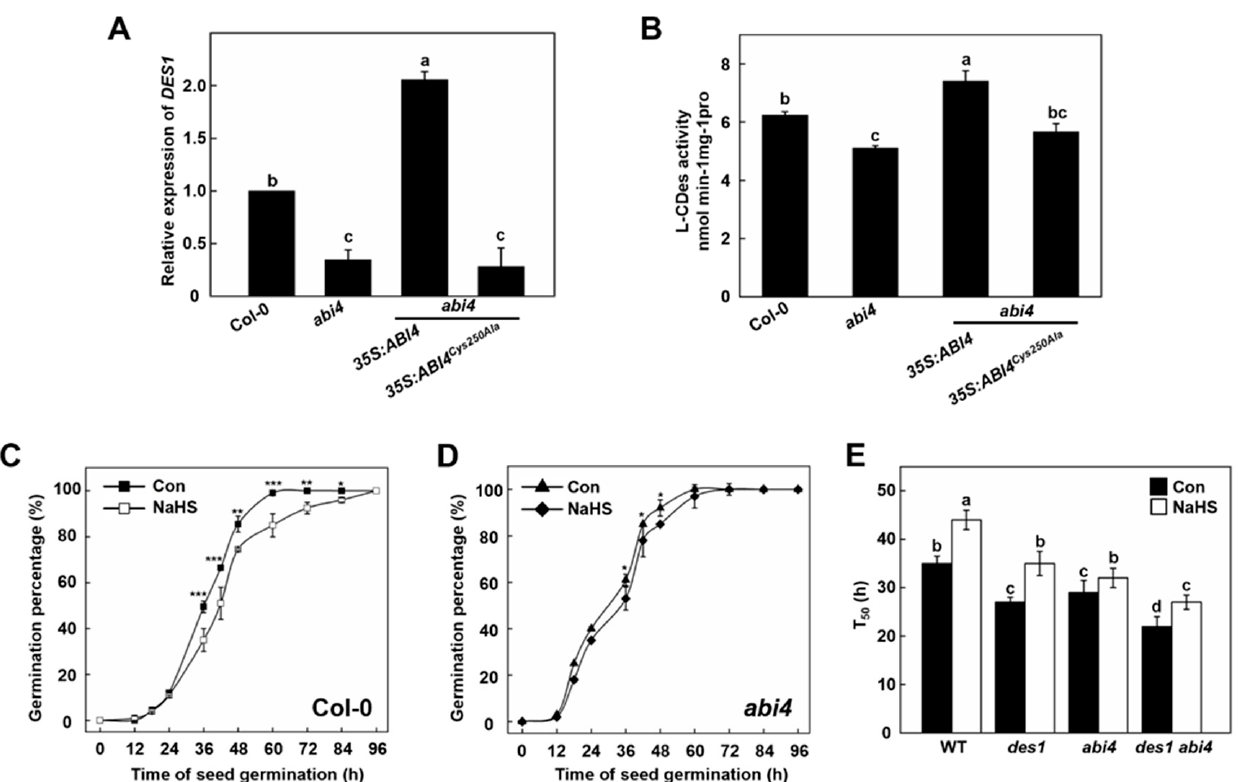
Figure 2. Functional analysis of DES1 and ABI4 on seed germination and post-germination growth. ( A , B ) Relative expression of DES1 ( A ) and L-CDes activity ( B ) in Col-0, abi4 , 35S:ABI4 abi4 , and 35S:ABI4 Cys250Ala abi4 Arabidopsis seedlings. Five-day-old seedlings were collected for qRT-PCR analysis and measurement of L-CDes enzyme activity, respectively. Expression levels are presented relative to that of UBQ10 , with DES1 expression in the Col-0 set to 100%. ( C , D ) Time-course changes of germination percentage in Col-0 and abi4 Arabidopsis seedlings upon NaHS treatment. Arabidopsis seeds were incubated on 1 / 2 MS medium containing 0.1 mM NaHS, respectively. The germination percentage (%) of seeds was counted at the indicated time points. ( E ) The time to obtain 50% of germinated seeds in WT, des1 , abi4 , and des1 abi4 seeds with or without 0.1 mM NaHS. Data are mean ± SE of three independent experiments with three biological replicates for each individual experiment. Bars with different letters indicate significant differences at p < 0.05 according to one- way ANOVA (post-hoc Tukey’s HSD test). Con: control. Asterisks represent significant differences between treatments according to Student’s t -test (* p < 0.05, ** p < 0.01, *** p < 0.001). Time-course changes of germination percentage were examined in WT and abi4 Ara- bidopsis seedlings upon NaHS treatment. While the germination speed of abi4 is faster than wild-type, NaHS-triggered inhibitory response in germination is weakened by the mutation of ABI4 (Figure 2C,D). The germination rates of des1 and abi4 mutant lines were further compared. Mutation of either DES1 or ABI4 reduced the time to have 50% ger- minated seeds (T50; Figure 2E). Meanwhile, the T50 index is significantly shortened in des1 abi4 double mutant than its parental lines, all of which were significantly increased by NaHS treatment. Furthermore, DES1 and ABI4 also showed additive effects with regard to seedling primary root growth (Supplementary Figure S3). Taken together, these results demonstrated that H 2 S and ABI4 have additive inhibitory effects during seed germination and the post-germination